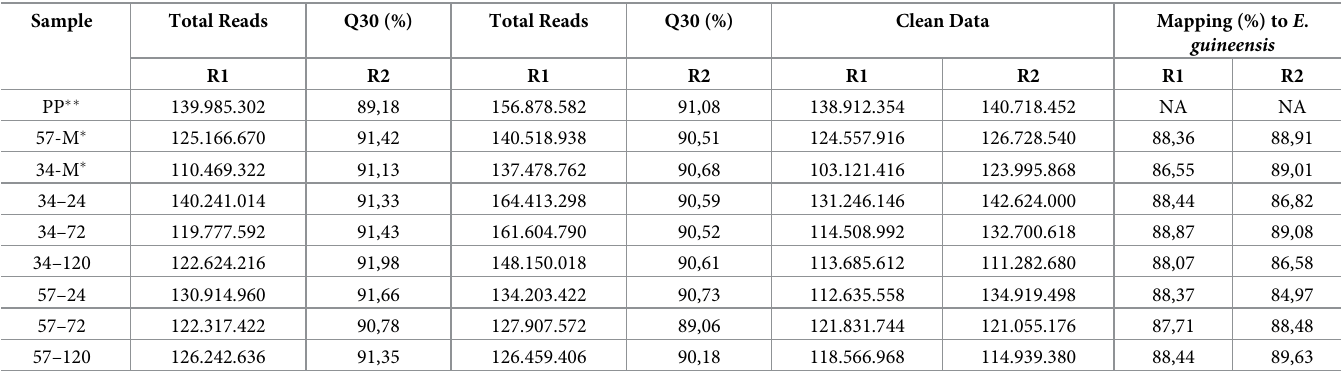
Table 1. Reads, quality and mapping percentage of transcriptomic data.